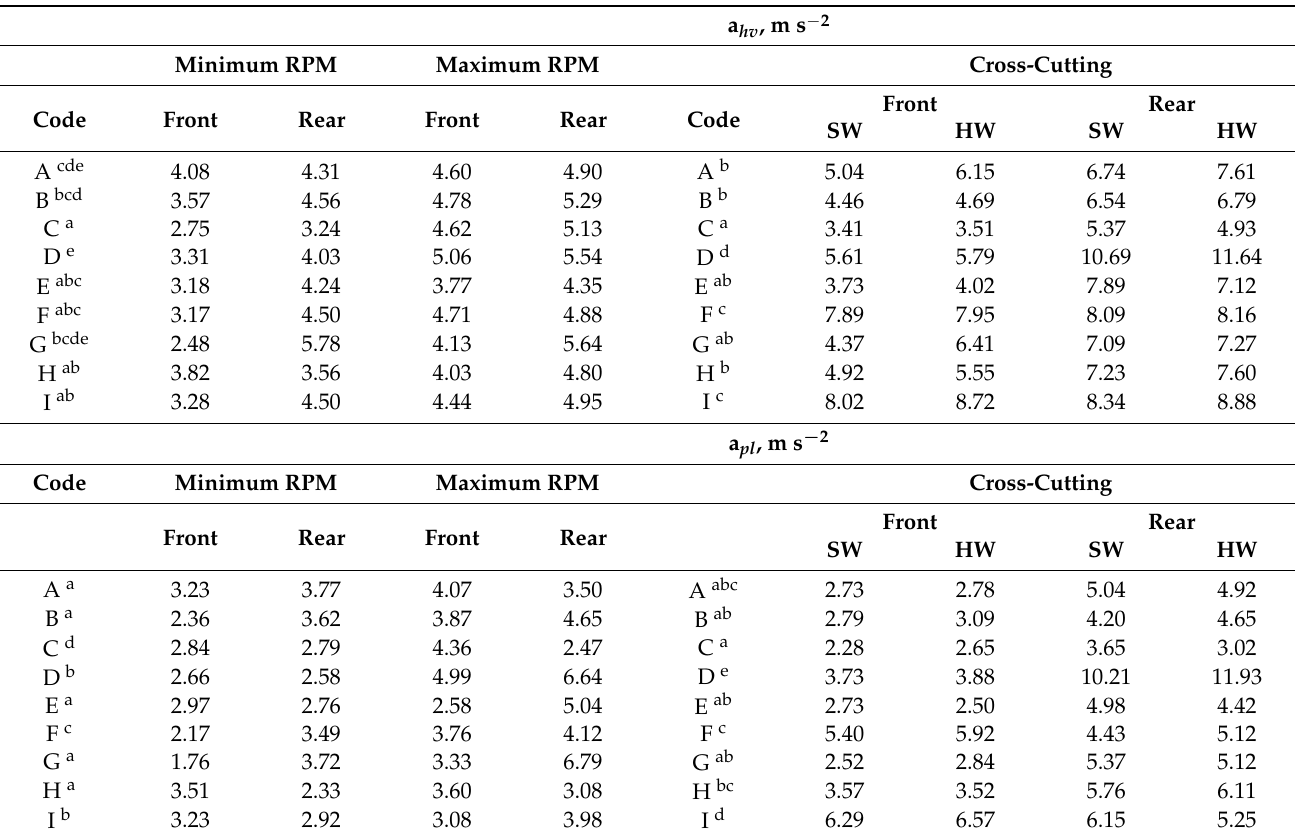
Table 2. Means of the vibration total value (a hv ) and mean of peak level (a pl